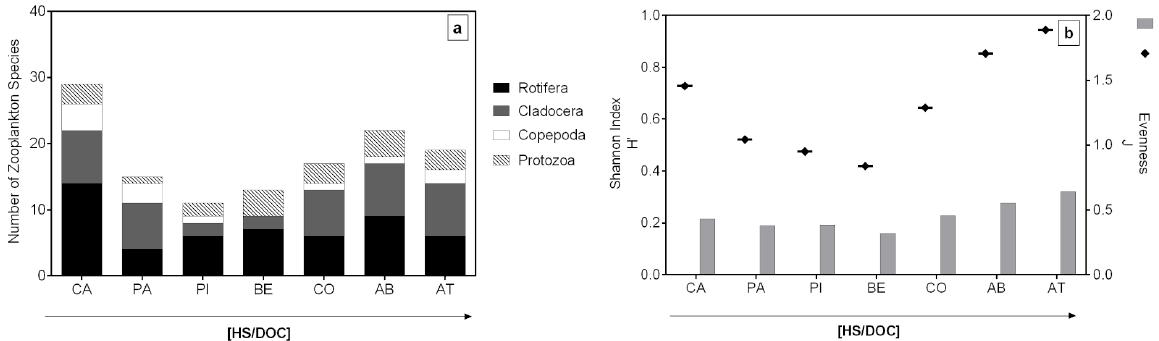
Figure 3. Species richness (a) and diversity (Shannon index, H’ and Pielou index, J – b) of zooplankton groups in all of the sampled environments along an increasing humic substances gradient. CA= Cabiúnas; PU= Paulista; PI= Pitanga; BE= Bezerra; CO= Comprida; AB= Amarra-Boi; AT=